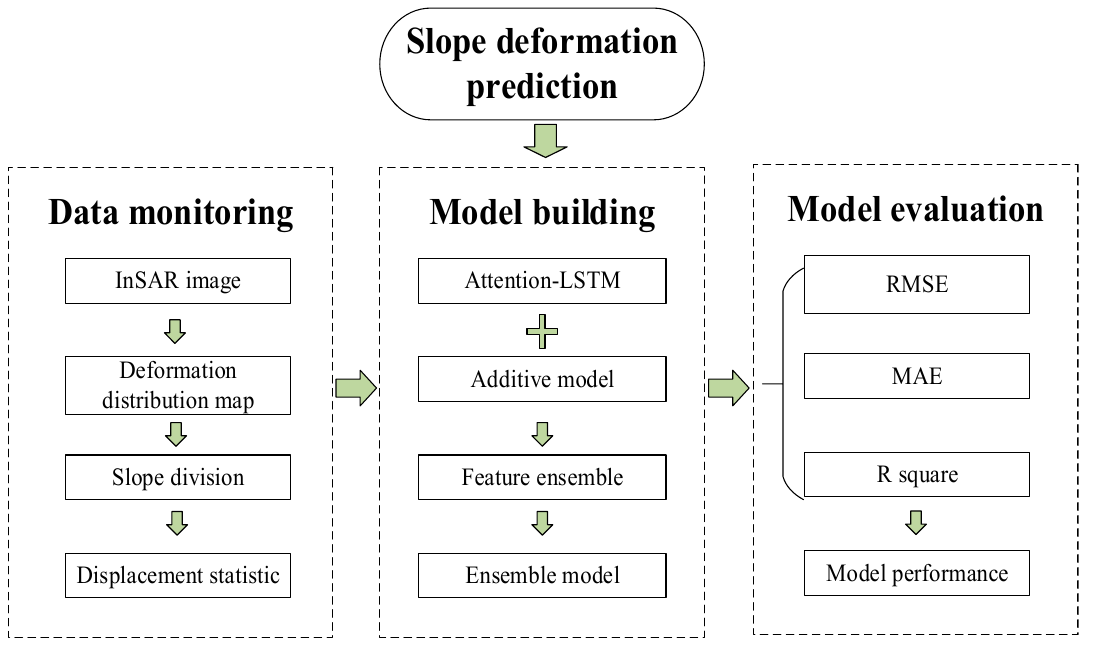
Figure 1. Overall framework and flowchart.